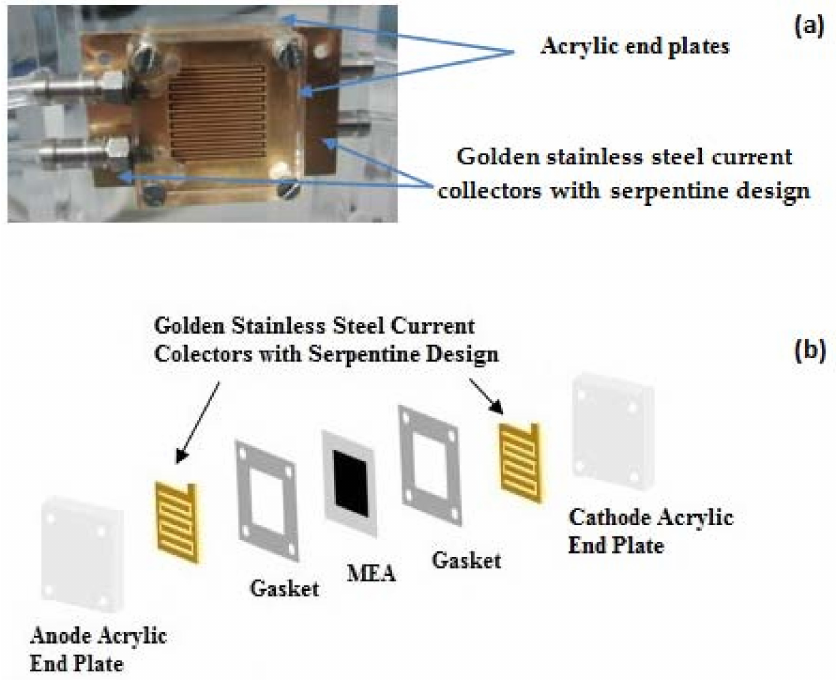
Figure 1. micro direct methanol fuel cell (MicroDMFC) ( a ) picture ( b ) drawing. MEA denotes membrane electrode